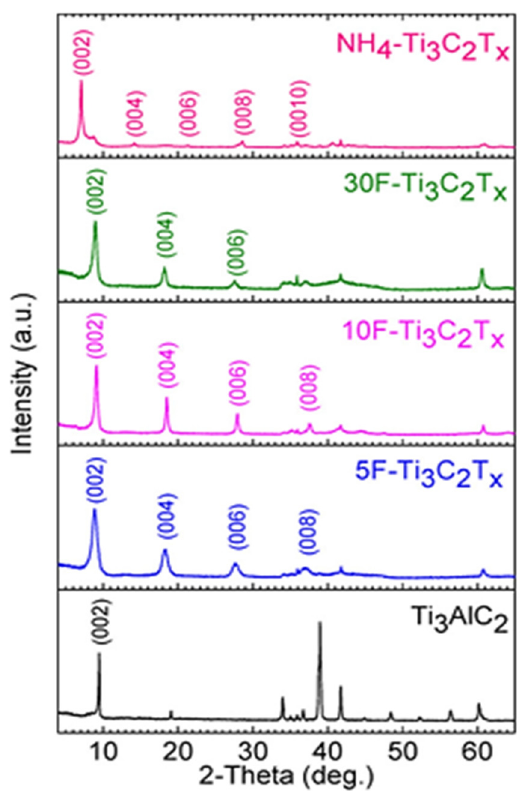
Figure 4. X-ray diffraction pattern of Ti 3 AlC 2 (MAX) powder and MAX powder etched with 30, 10, and 5 wt.% HF and ammonium hydrogen fluoride etching routes [29]. Copyright 2017, American Chemical Society.